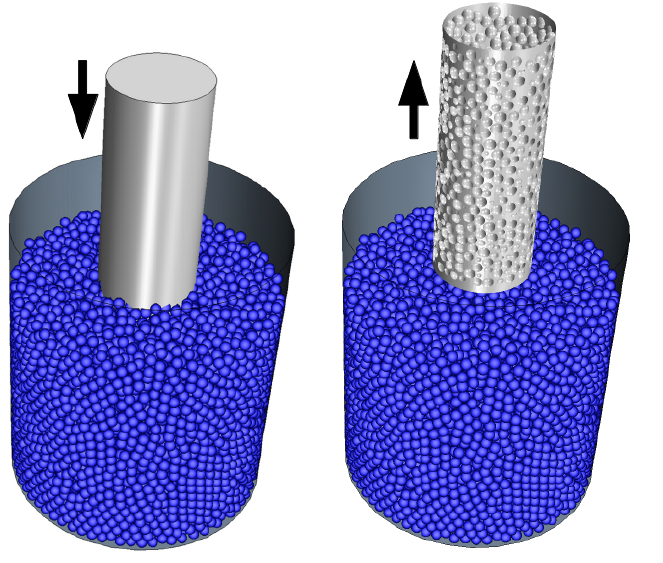
Figure 4. Outline of the process for generating an irregular wall